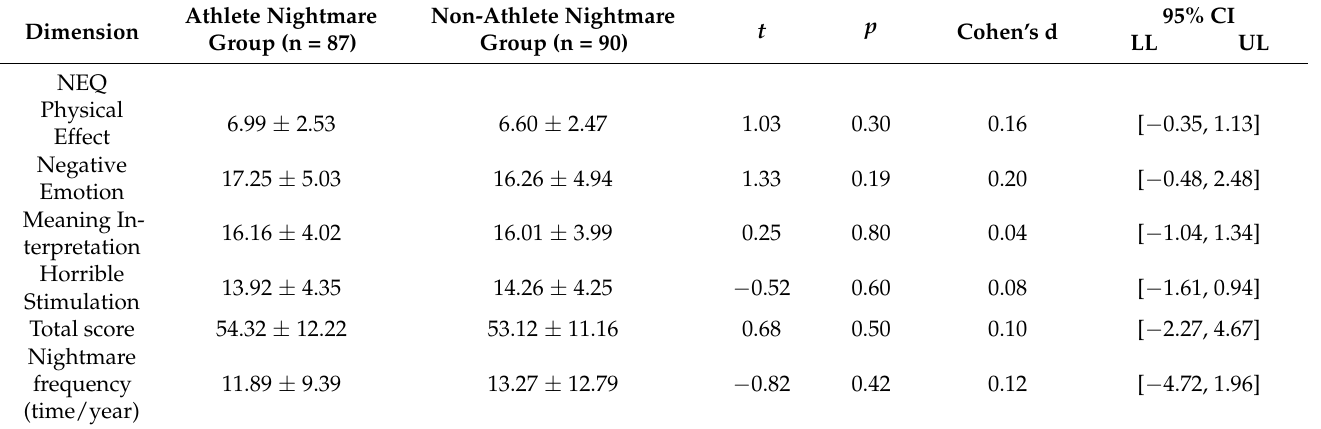
Table 2. Comparison of NEQ dimensions between the athlete nightmare group and the non-athlete nightmare group (mean ± SD).